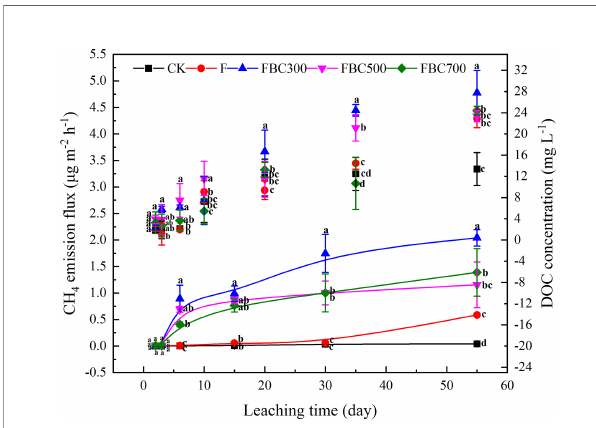
FIGURE 2 | Temporal changes of methane (CH 4 ) emission fl ux and surface water dissolved organic carbon (DOC) during 55 days column leaching of paddy soil incorporated with or without biochar amendments and/or fertilizer (i.e. CK: Control treatment without biochar and fertilizer; F: Only fertilizer added; FBC300: 300°C biochar combined with fertilizer; FBC500: 500°C biochar combined with fertilizer; FBC700: 700°C biochar combined with fertilizer). Scatter diagram represented DOC dynamic changes. Curve chart represented CH 4 emission fl ux. Letters represent the different statistical classes among the treatments at p